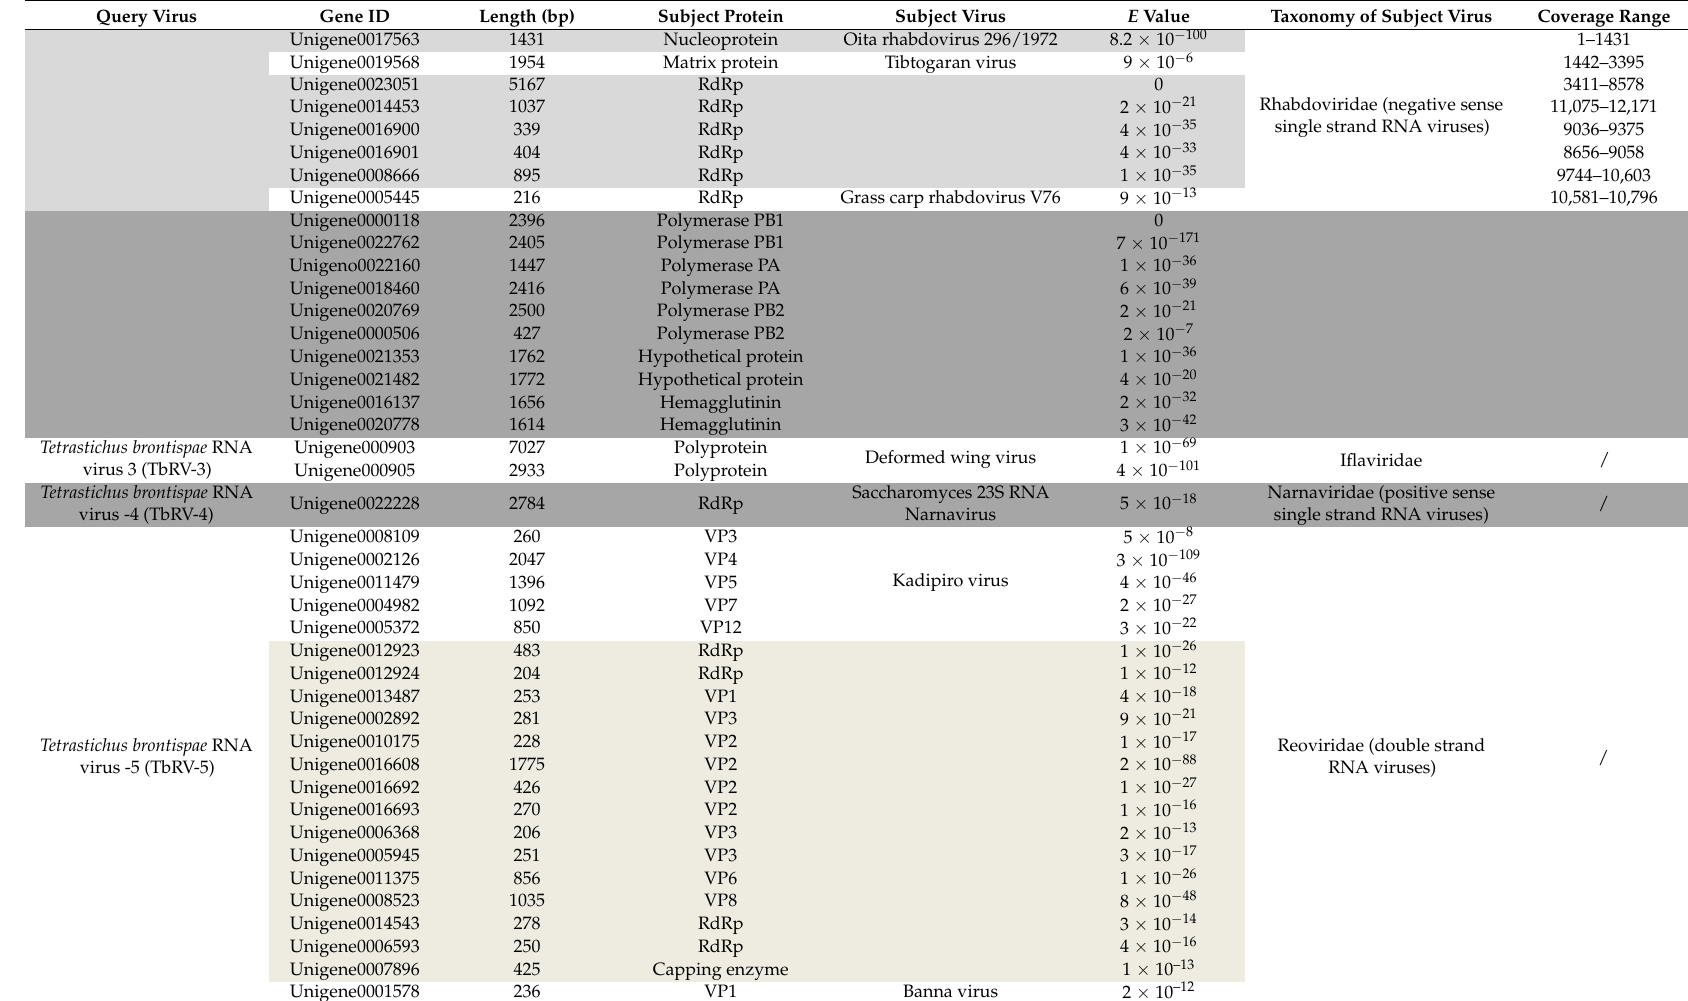
Table 1. Virus species identified through transcriptome